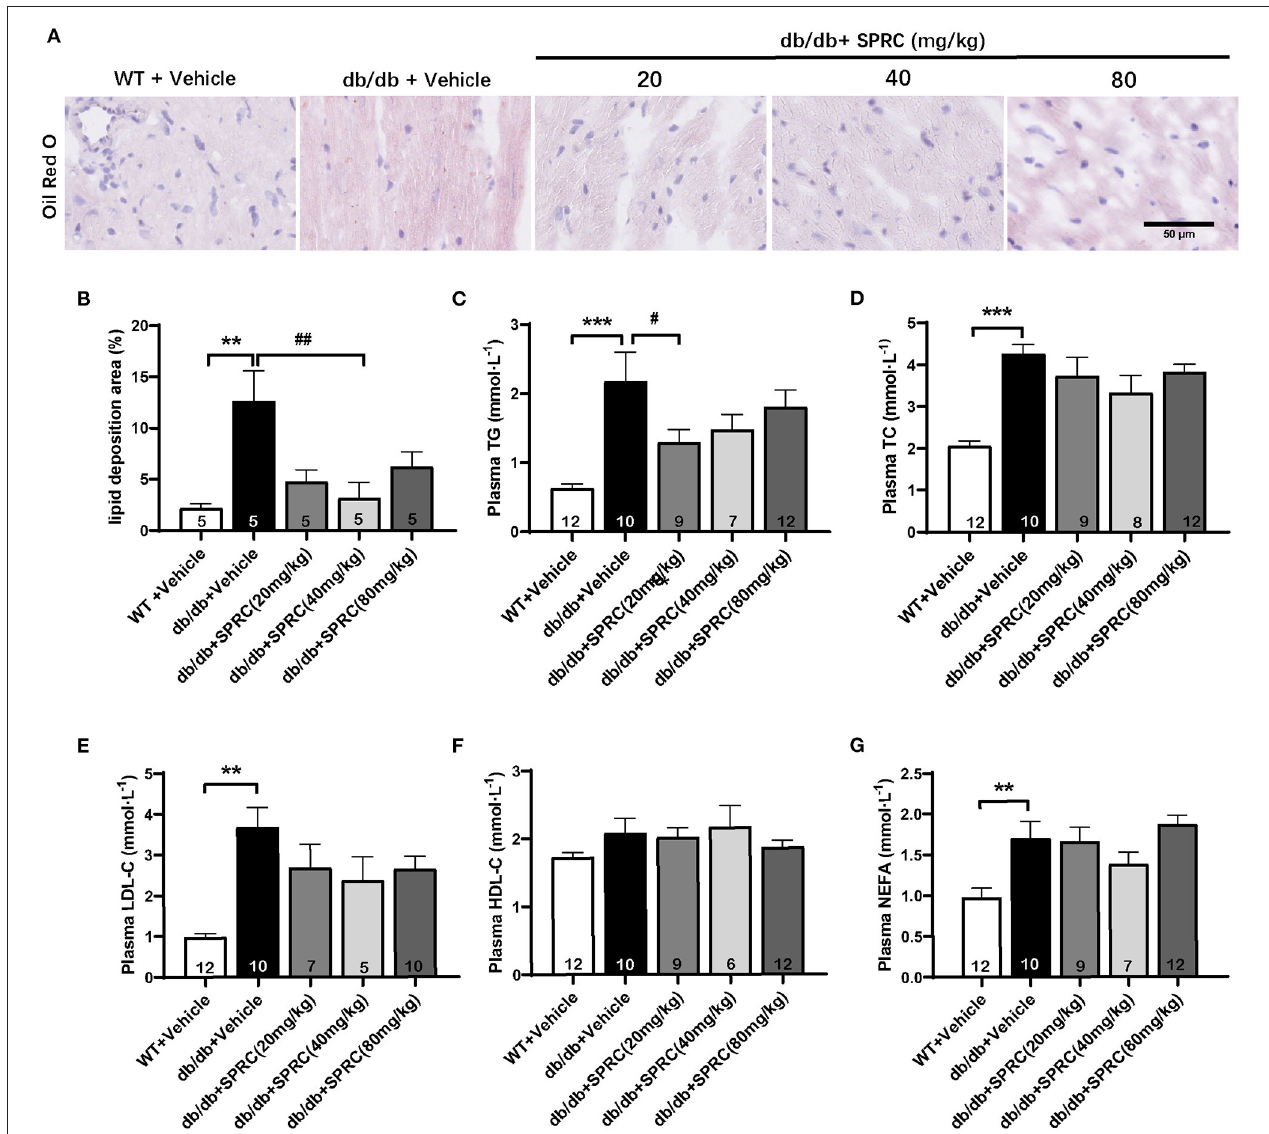
FIGURE 4 | SPRC treatment reduces myocardial lipid accumulation and dyslipidemia in db/db mice. Vehicle or SPRC (20, 40, or 80 mg/kg/day) was orally administered to WT mice or db/db mice for 12 weeks. Heart tissue specimens and plasma were collected. (A) Oil Red O staining of myocardium were performed ( n = 5) lipid deposition area (B) was shown. The levels of TC (C) , TG (D) , LDL-C (E) , HDL-C (F) , NEFA (G) were measured ( n = 5–12). Values are presented as means ± SEM. ** P < 0.01, and *** P < 0.001 vs. WT + Vehicle group, # P < 0.05, ## P < 0.01 vs. db/db + Vehicle